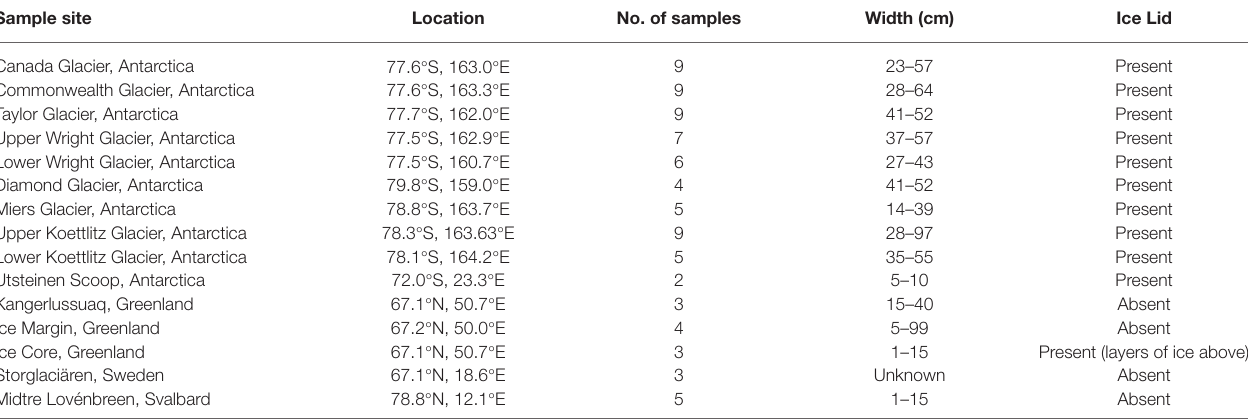
TABLE 1 | GPS locations and site names for cryoconite samples from the Arctic and Antarctic. Sample